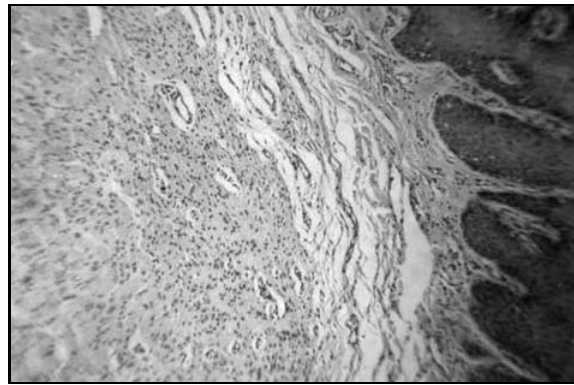
Figura 3 – Aspecto microscópico (HE, 4x)